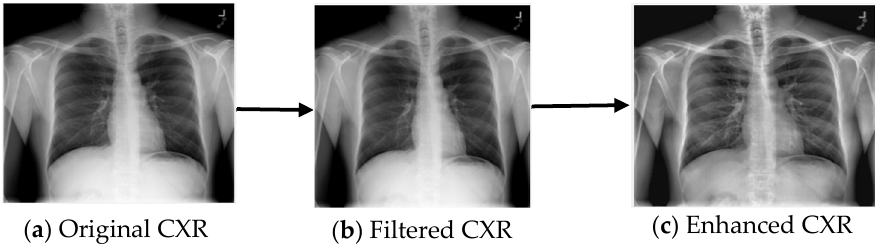
Figure 4. Image preprocessing using median filter and CLAHE .